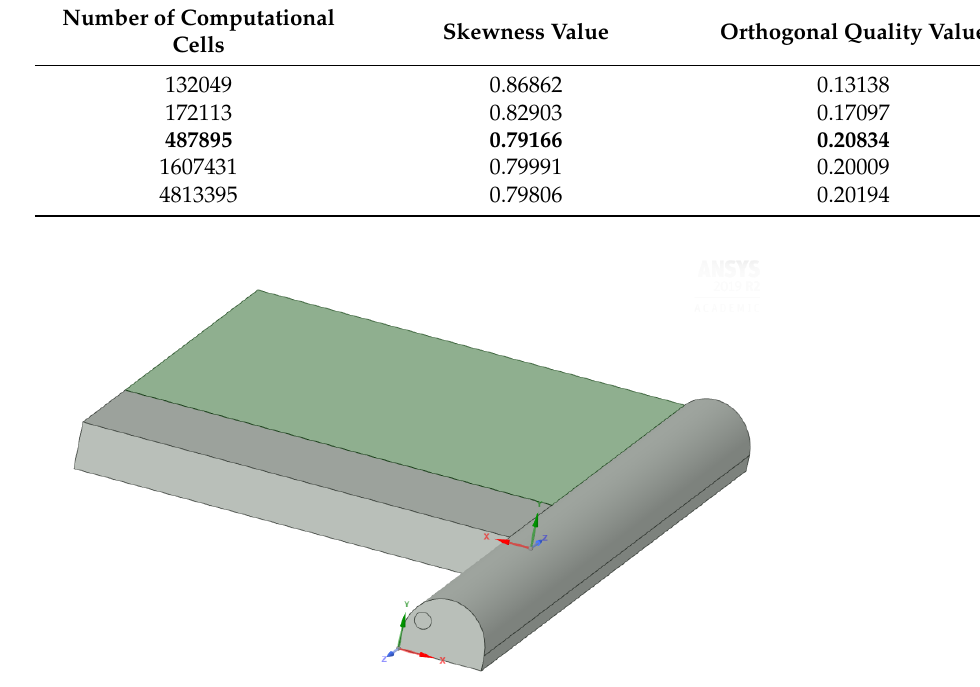
Figure 3. Geometric model of the A-15 longwall and the goaf section part.